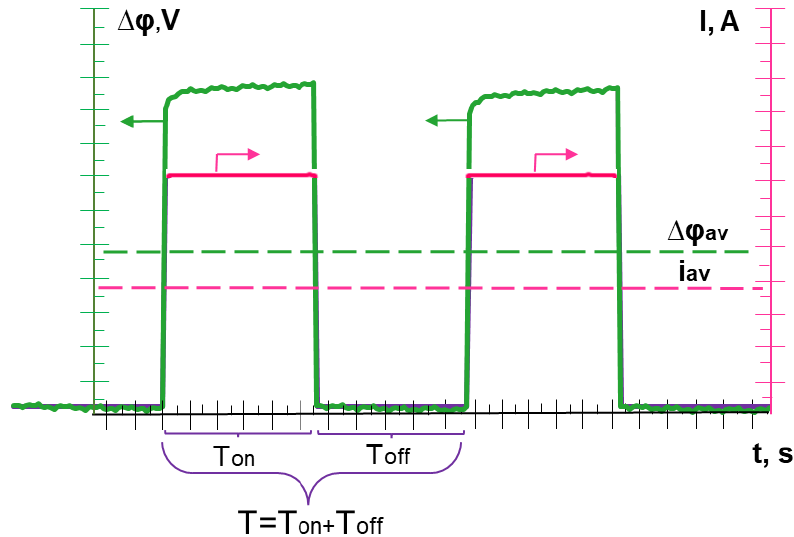
Figure 2. The applied current densities and the corresponding potential drops vs. time in the PEF mode. The dotted lines indicate the average values of i av and Δφ av for the period.